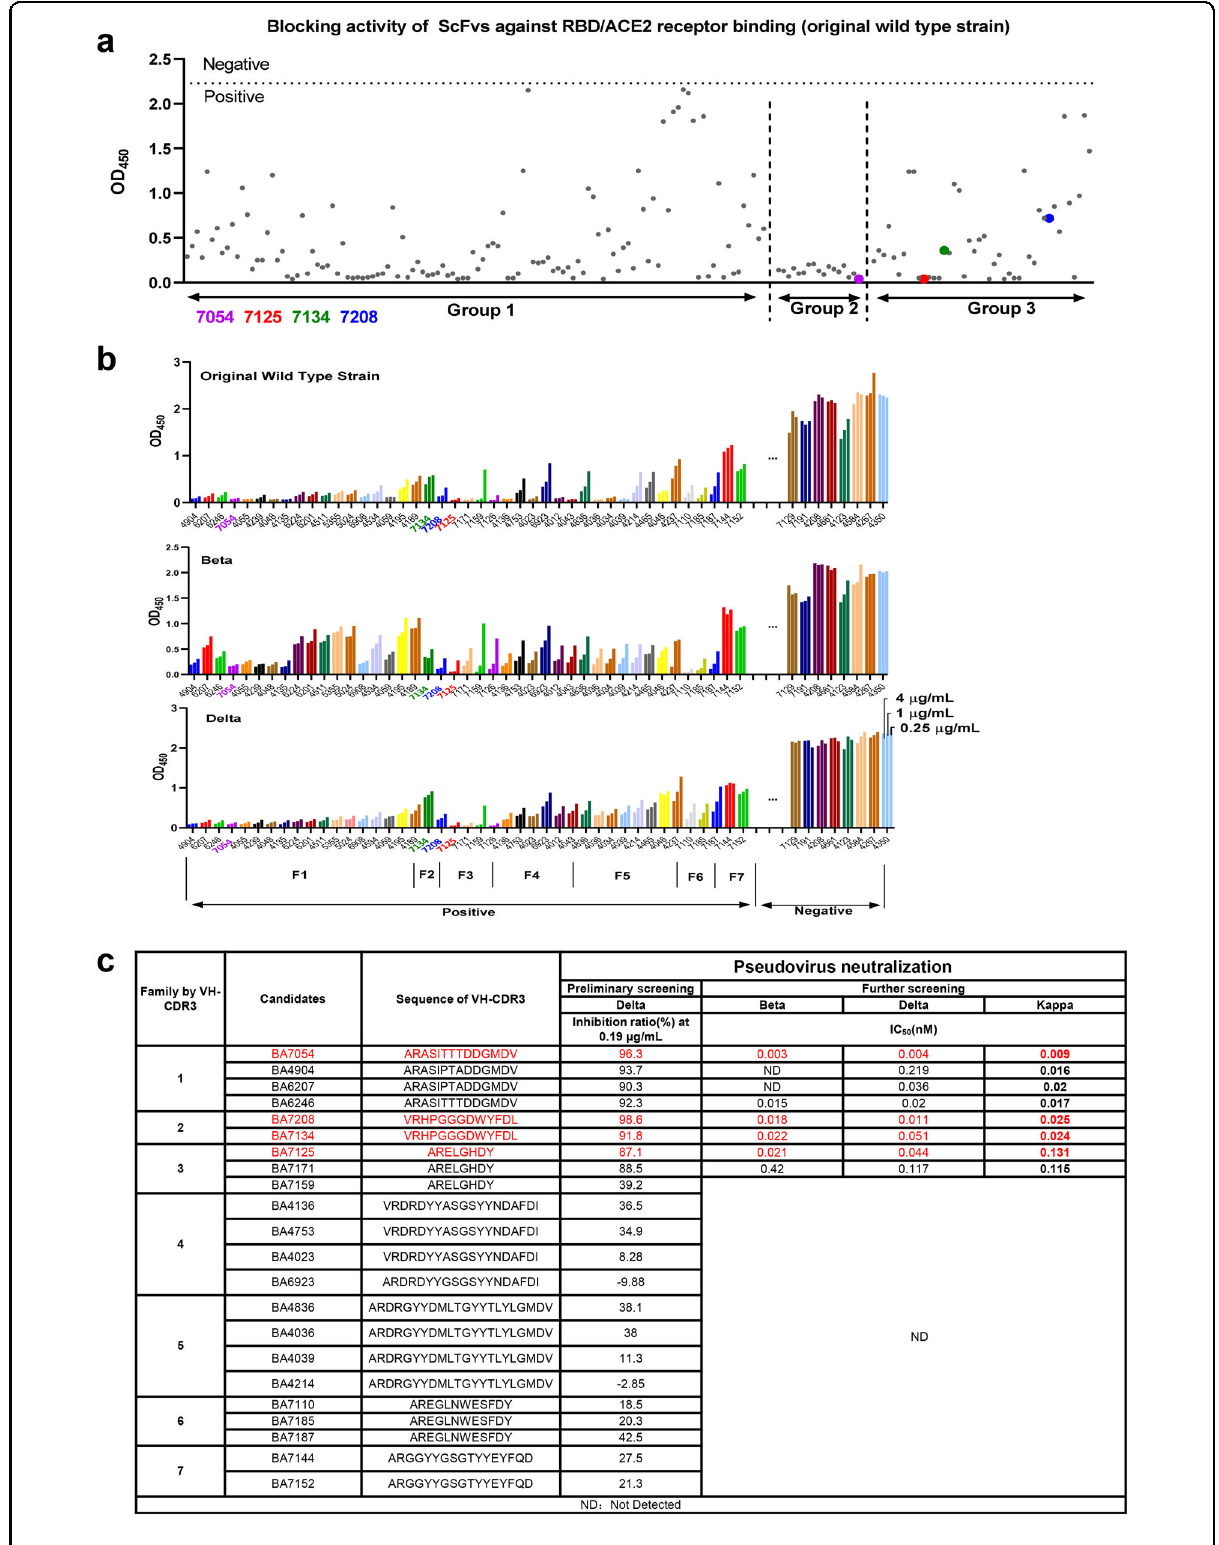
Fig. 1 (See legend on next